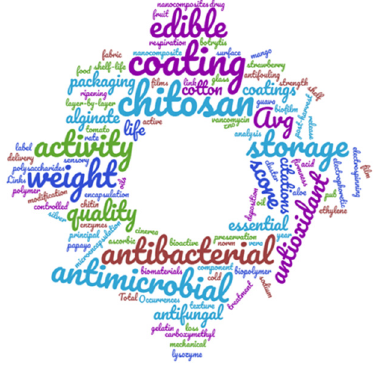
Figure 2. Word cloud extracted from nubedepalabras.es.